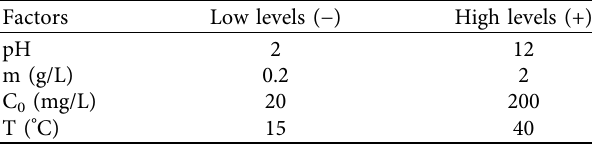
Table 2: Process factors and their levels.